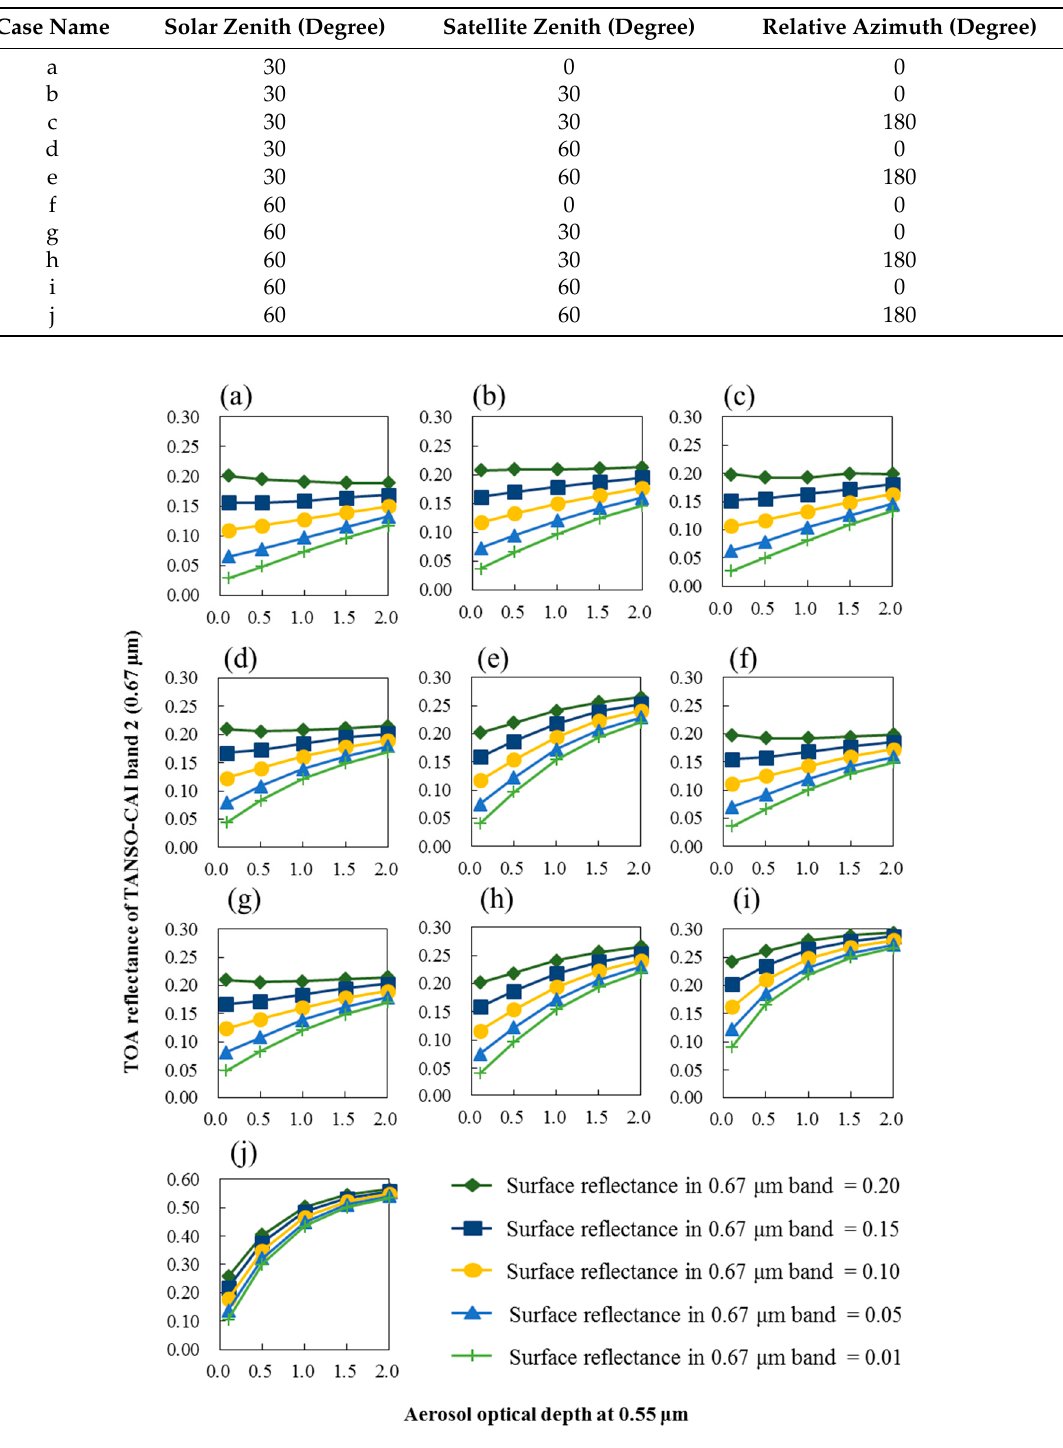
Figure 9. GOSAT TANO-CAI top-of-atmosphere (TOA) reflectance at 0.67 µm as a function of aerosol optical depth (AOD) under different surface reflectances; ( a – j ) are simulated under the corresponding observation geometric conditions cases of ( a – j ) shown in Table 3.